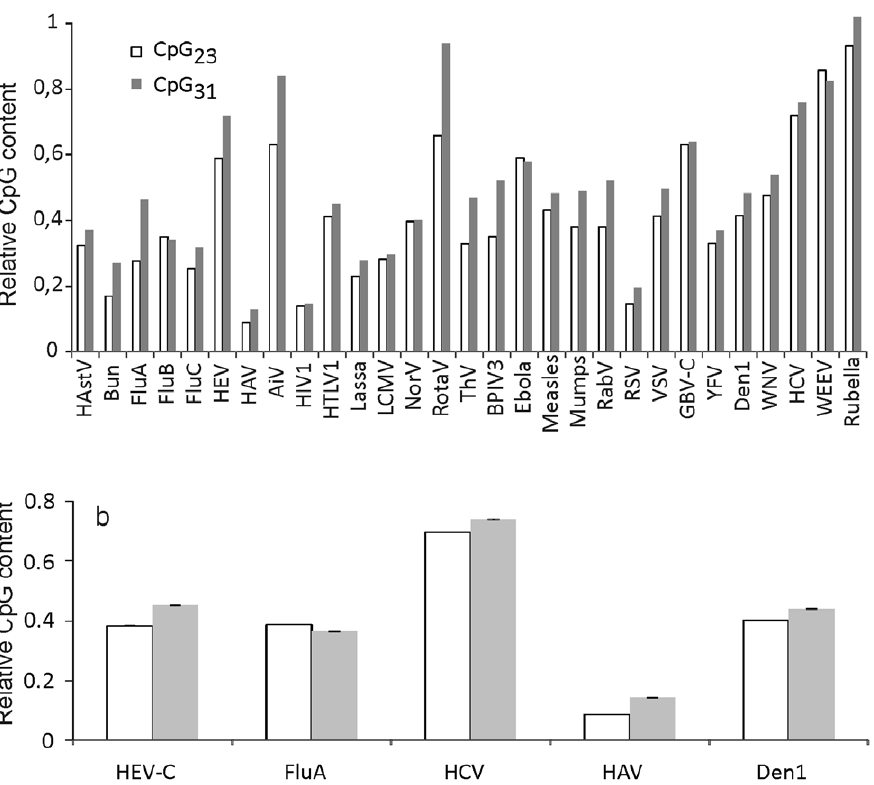
Figure 2. CpG content at different codon positions in RNA viruses. (A) Relative CpG dinucleotide content at codon positions 2-3 and 3-1 in RNA viruses (Table 1) was calculated as a ratio of the observed CpG content to the expected, calculated as the product of genomic nucleotide frequencies at the corresponding codon positions, e.g. £ [C 2 ] 6 £ [G 3 ] for CpG 23 dinucleotide. (B) Mean relative CpG dinucleotide content in extended datasets of five RNA viruses. White, codon positions 2-3; gray, codon positions 3-1. Error bars indicate standard errors of the mean. Virus name acronyms are provided in Table 1.